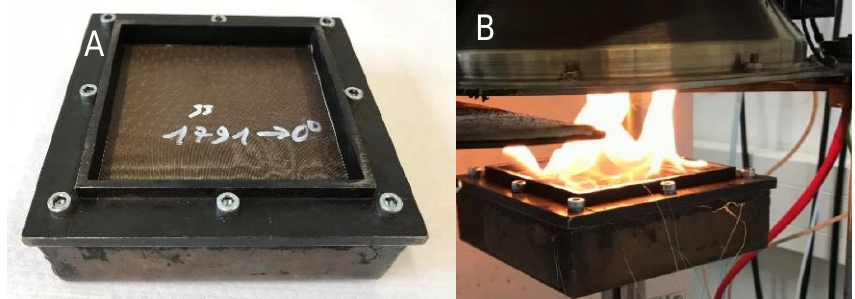
Figure 2. Sample holder with a horizontally installed CFRP panel ( A ) used for the fire tests in a cone calorimeter ( B ). (For reference measurements of the fire accelerant, the CFRP panel is substituted by a steel plate. Vertically aligned CFRP panels are positioned at the right edge of the frame with a horizontal steel plate in the sample holder.).